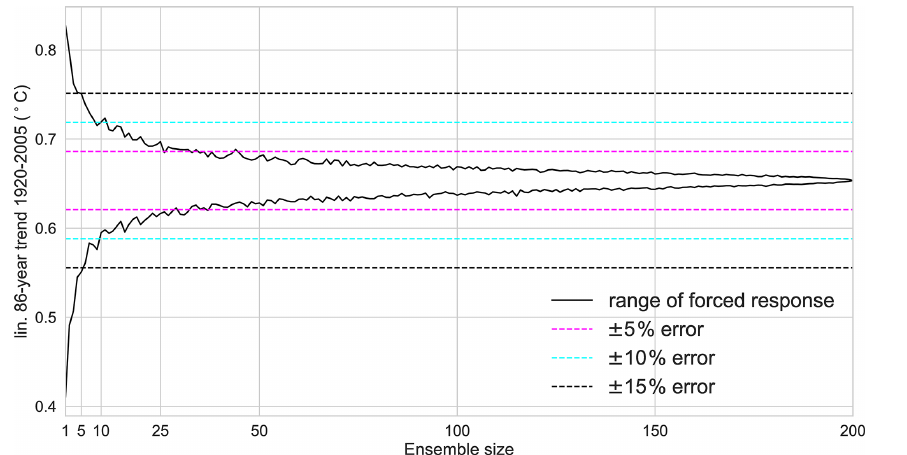
Figure 5. Linear warming trend from 1920 to 2005 for different ensemble sizes shown as a linear trend fitted to the ensemble mean. Black lines show maximum and minimum 86-year ensemble mean temperature trend from 1000 random samples. Errors are shown as percentage of the 200-member ensemble mean temperature trend.